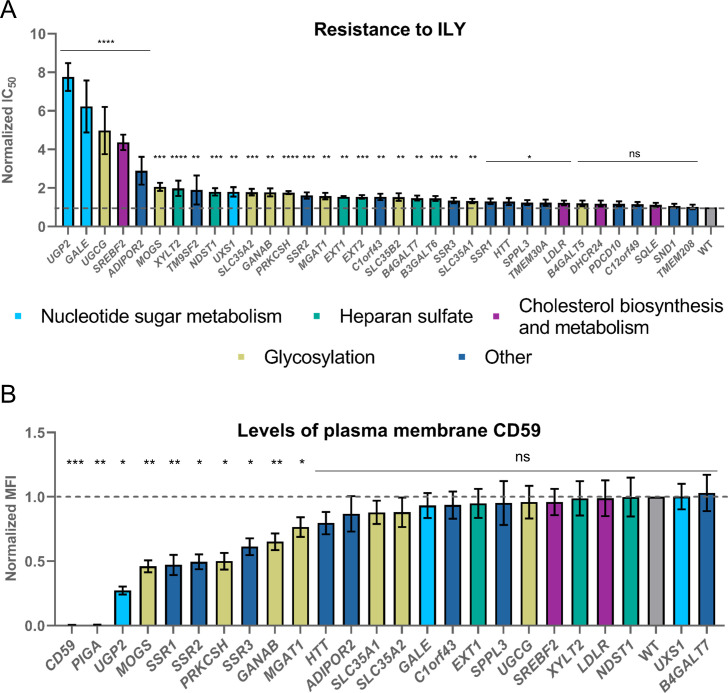
Validation of the hits from the intermedilysin CRISPR knock-out screening.A. Resistance to ILY conferred by the knock-out of all tested genes. Values were normalized by dividing the raw IC50 value by the IC50 value for ILY in WT HAP-1 cells. The dashed line shows the WT IC50 value. n = 3, error bars represent standard deviations. p-values were calculated using two-tailed t-test; *–<0.05; **–<0.01, ***–<0.001; ****–<0.0001. Significance was calculated in relation to the WT cell line. B. CD59 protein is depleted in CD59 and PIGA knock-out cell lines and significantly reduced in N-glycosylation mutant cell lines as well as TRAP complex gene (SSR1, SSR2, and SSR3) knock-out cell lines. Cells were labeled with anti-CD59 antibody (OV9A2) conjugated with APC and FACS sorted. Median fluorescence intensity (MFI) in the APC line was compared between WT and knock-out cell lines. Values were normalized by dividing the raw MFI value of a knock-out cell line by the raw MFI value for WT HAP-1 cells. The dashed line shows the WT normalized MFI value. Error bars represent standard deviations from the mean of the medians of at least two technical replicates. Each median was calculated from at least 15000 events. p-values were calculated using two-tailed t-test; *–<0.05; **–<0.01, ***–<0.001.